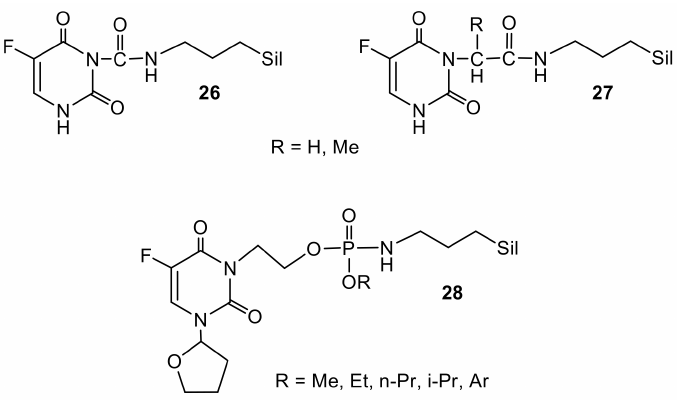
Figure 7. Chemical structures of silatranyl anticancer agents ( 26 – 28